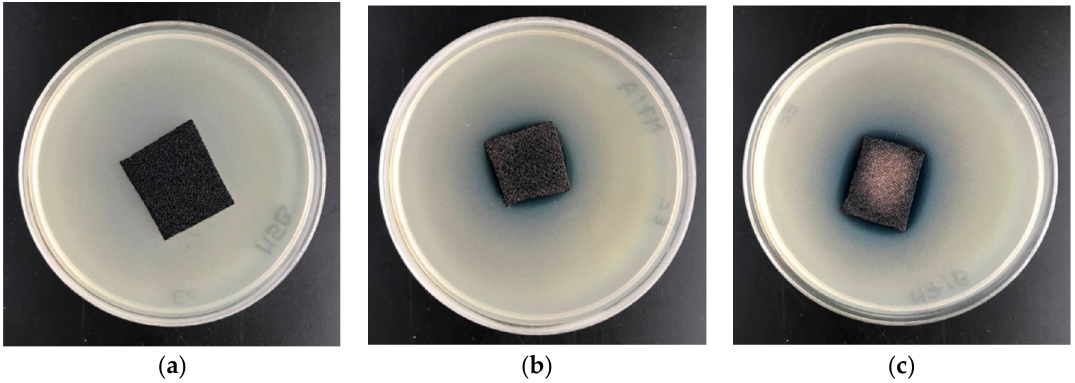
Figure 8. The PET samples coated with copper modifier antimicrobial activity tests. Inhibition zones of Escherichia coli bacterial growth on Petri dishes: ( a ) PETE, ( b ) PETE-Cu (0) -1; ( c ) PETE-Cu (0) -2. The similar pictures have been obtained for PETE and PETE-Cu (0) against Staphylococcus aureus species.